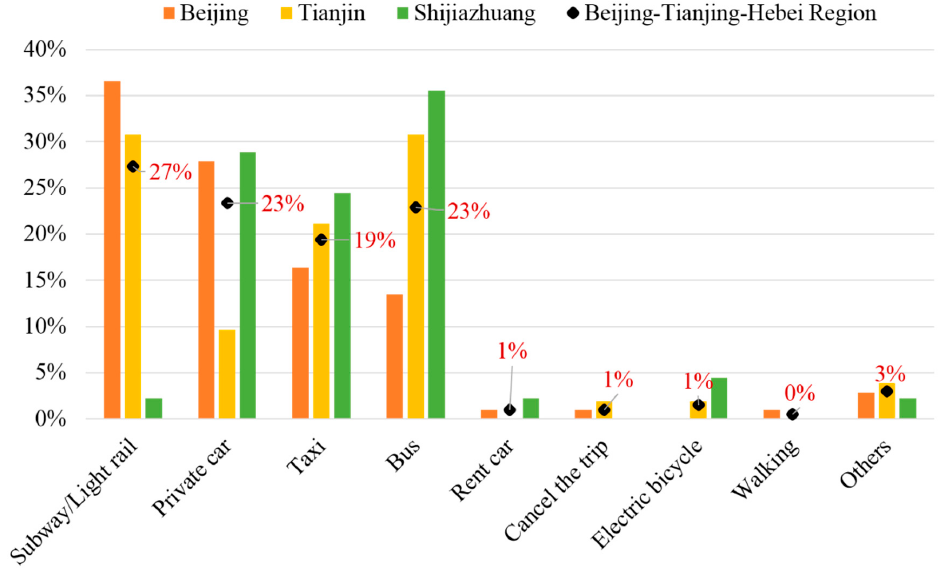
Figure 9. Survey results on users’ alternative travel modes in the absent of